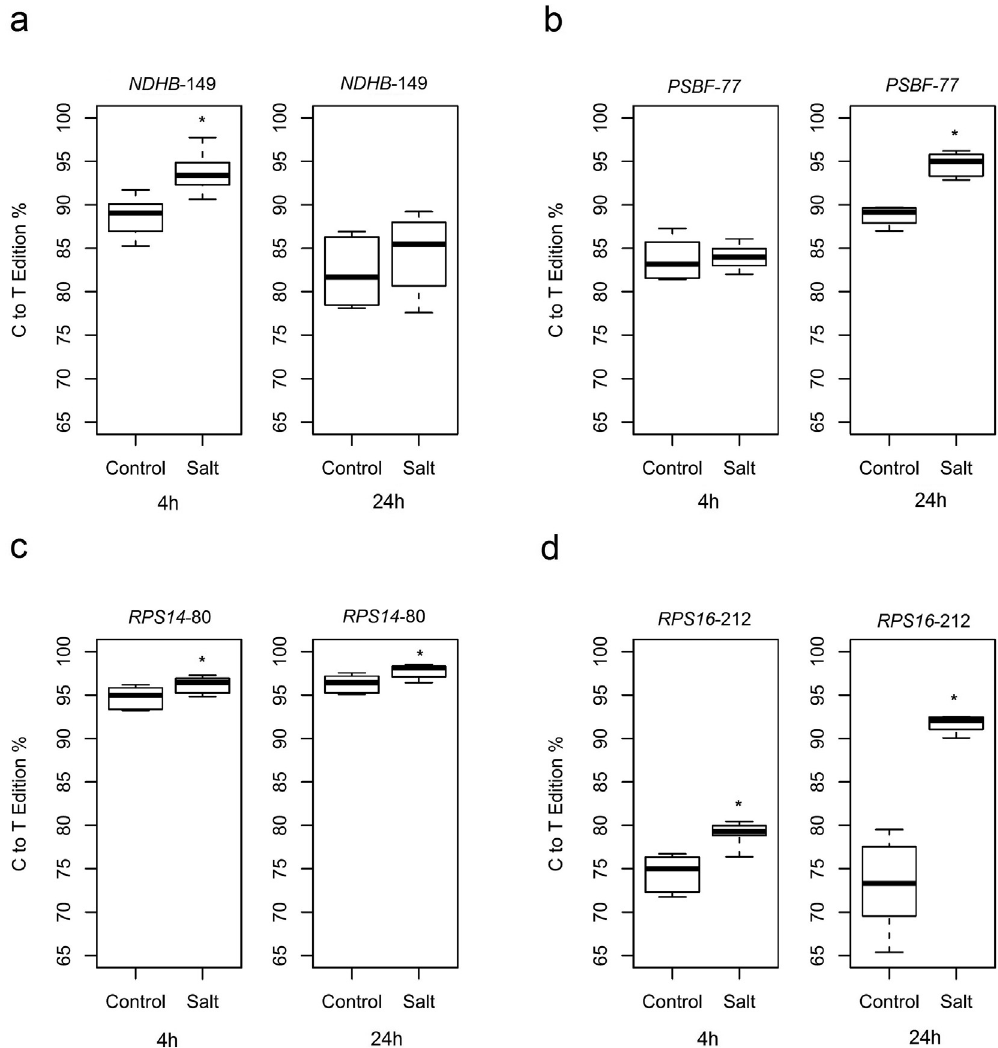
Figure2 -Boxplotindicatingtheeditingof(a) NDHB -149,(b) PSBF -77,(c) RPS14 -80,and(d) RPS16 -212sitesofcontrolandsaltstressplants,in4hand 24 hours treatment. Box area represents the lower and the upper percentiles. The upper whisker of the boxplot indicates the highest editing value ob- served; the lower whisker, the lowest editing value; and the middle line, the median editing value. Asterisk indicate significantly different values at P <